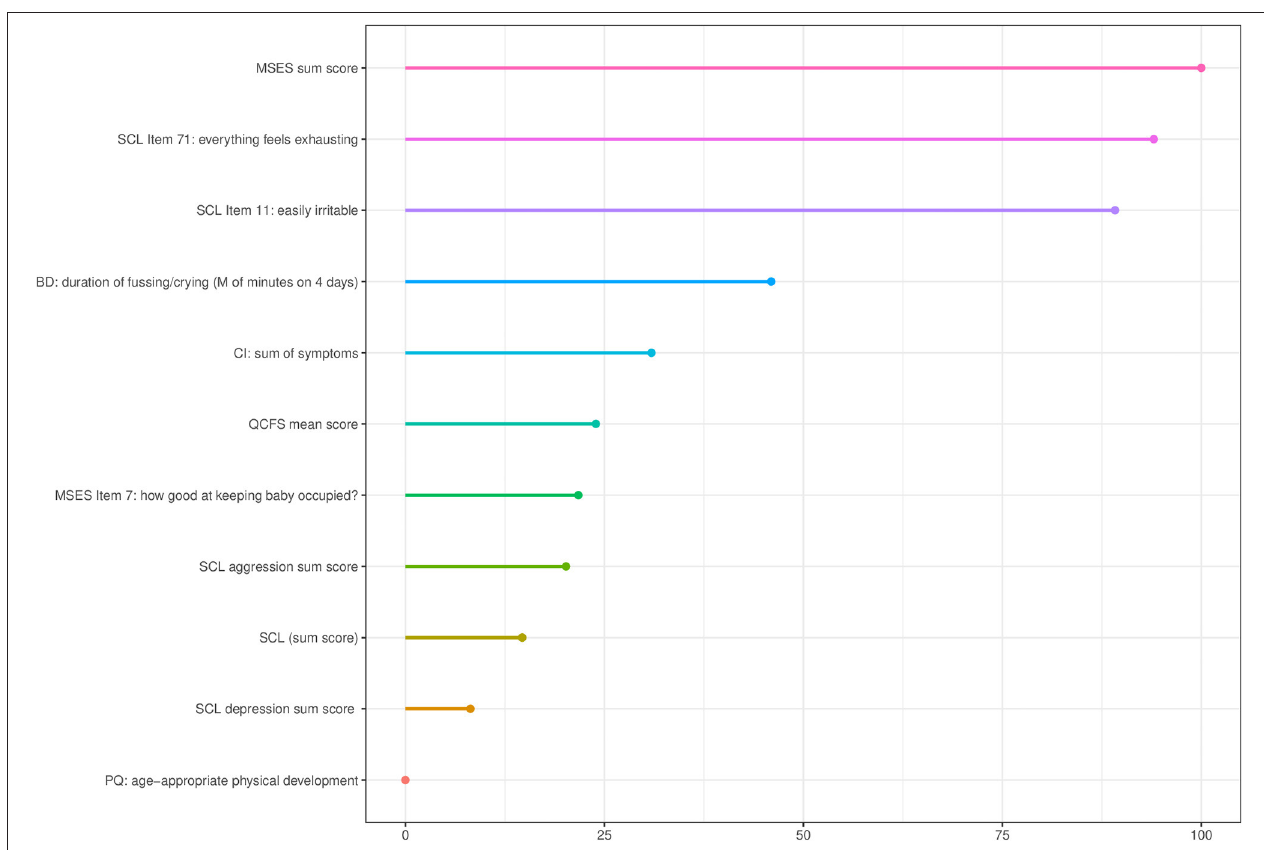
FIGURE 1 | Relative importance of variables in predicting PSI extracted from the tuned model. CI, Clinical interview; MSES, Maternal Self-Efficacy Scale; QCFS, Questionnaire for Crying, Feeding, and Sleeping; SCL, Symptom-Severity-Check-List-90R-S; PQ, Parent-Questionnaire; PSI, Parenting Stress Index; BD, 96-hour behaviour diary.